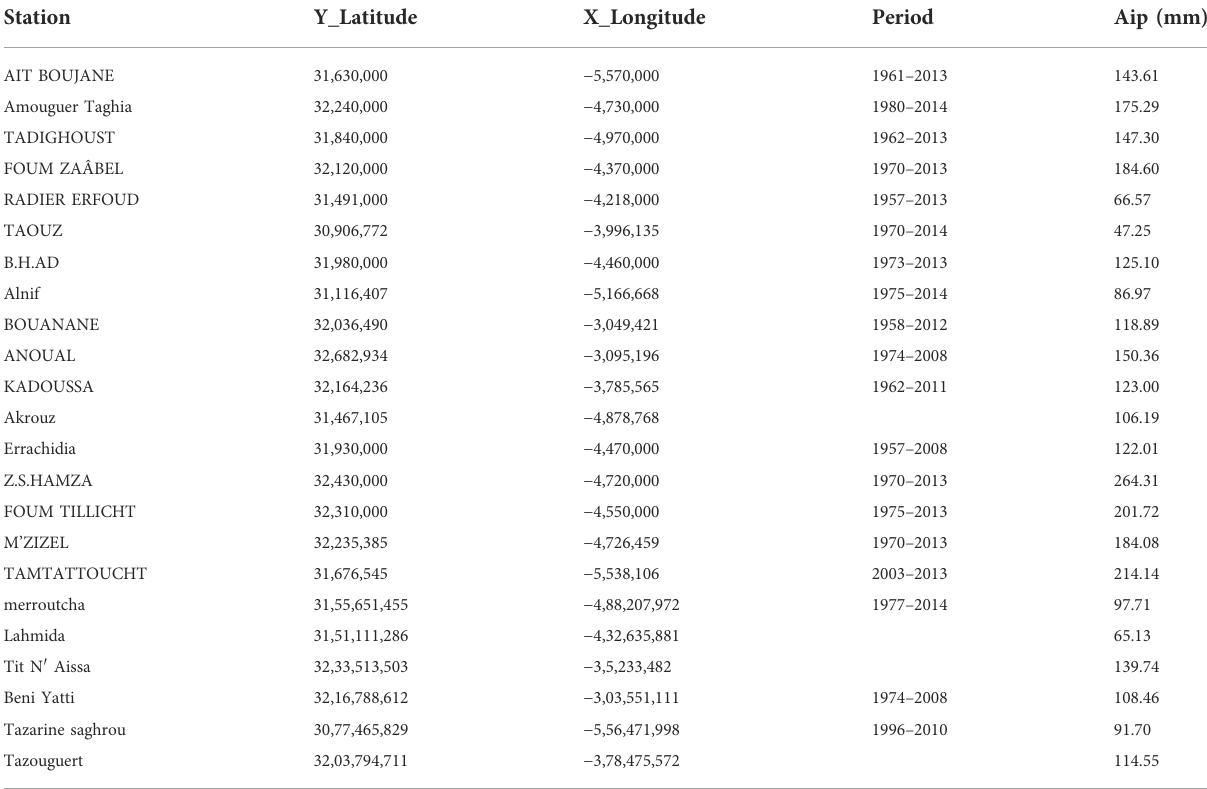
TABLE 1Totalannual rainfallandmonthlyrainfall. Source ofdata:archives of the “ Agencedes Bassins HydrauliquesGZRM. ” AIP:Average interannual precipitation. Station